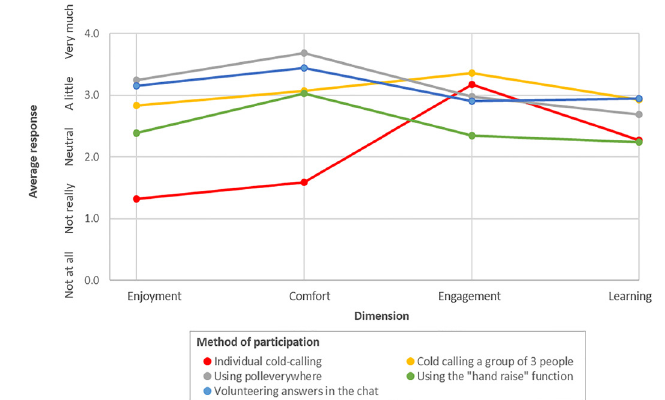
Figure 2. Class participation. Average response to the question “How much did [method of participation] help with your [dimension] during